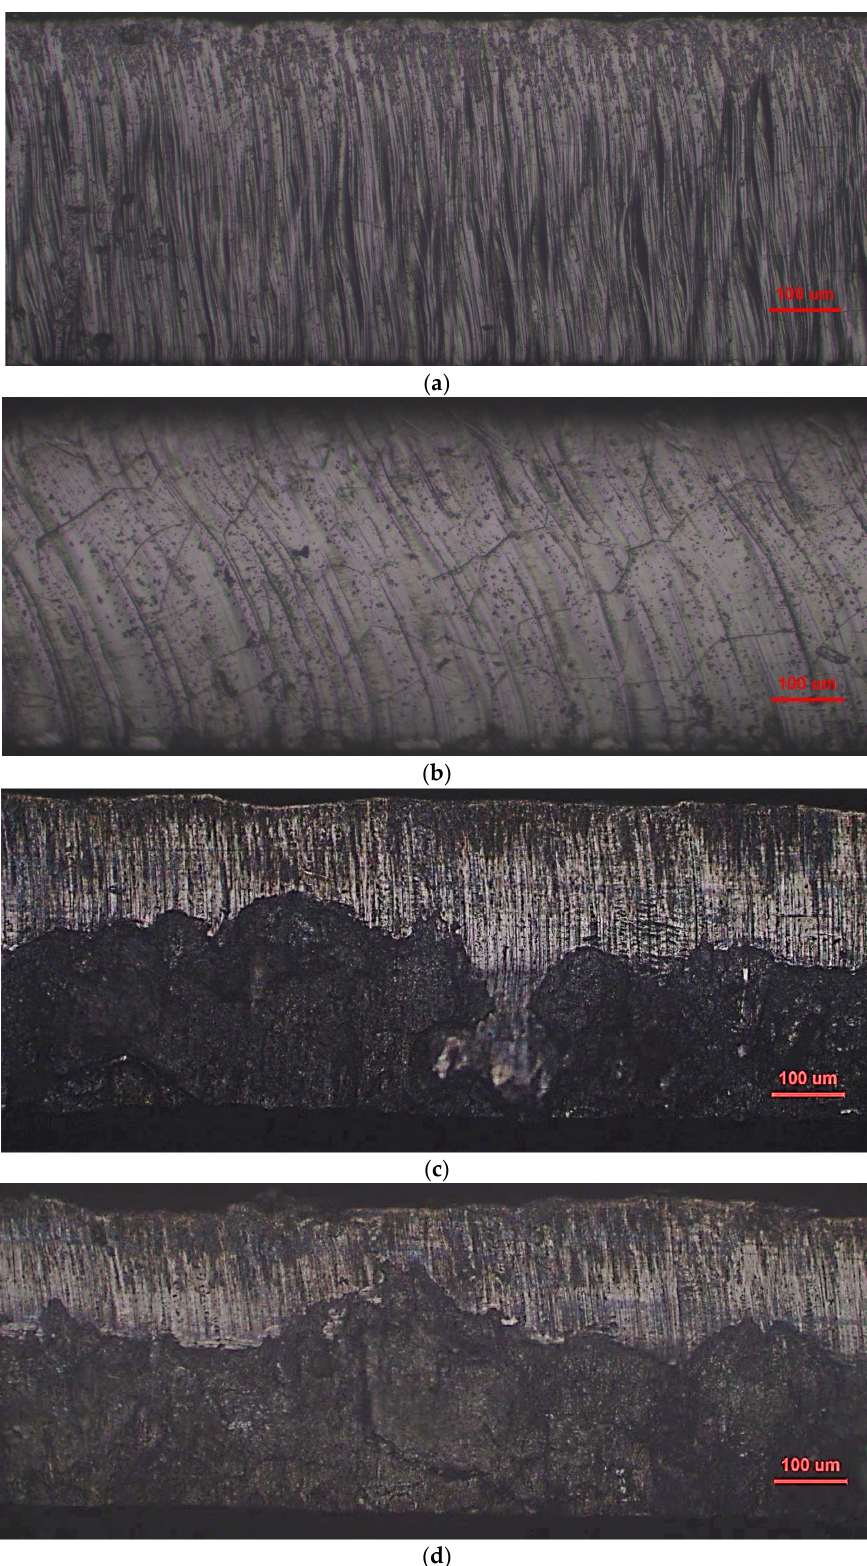
Figure 6. Optical morphology of cutting edge for laser cutting and mechanic shearing. ( a ) No. 7 sample manufactured using laser cutting; ( b ) No. 21 sample manufactured using laser cutting; ( c ) No. 7 sample manufactured using mechanic shearing; ( d ) No. 21 sample manufactured using mechanic